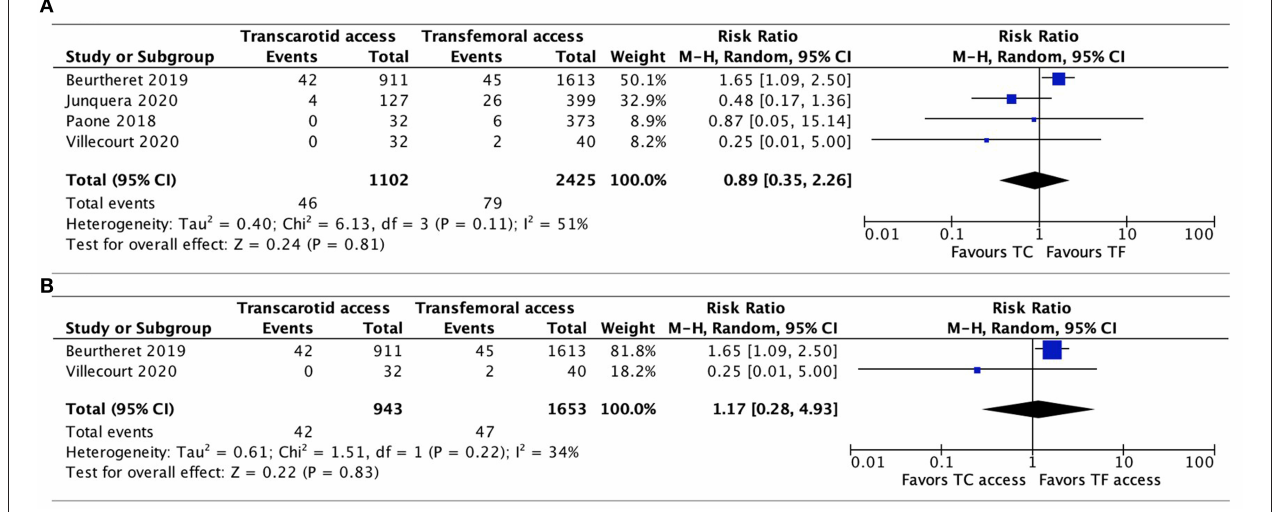
FIGURE 7 | Forest plots comparing acute kidney injury between TC and TF transcatheter aortic valve replacement procedures. (A) Pooled data from available studies. (B) Data from propensity-score matched studies. TC, transcarotid; TF,